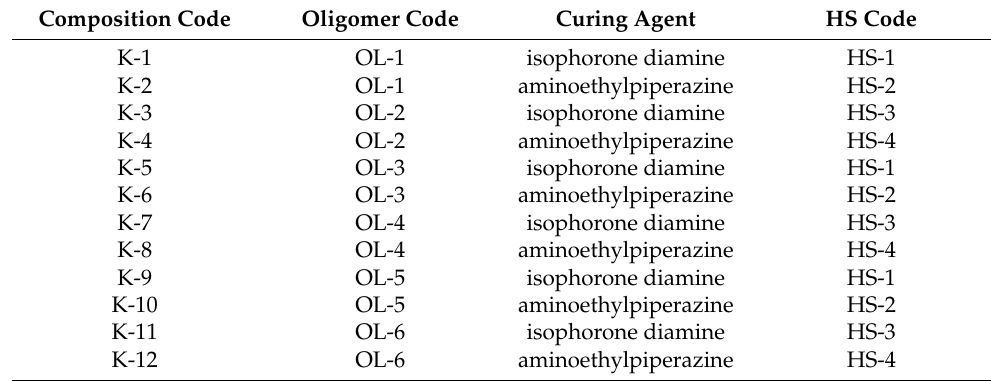
Table 3. Composition and properties of the synthesized